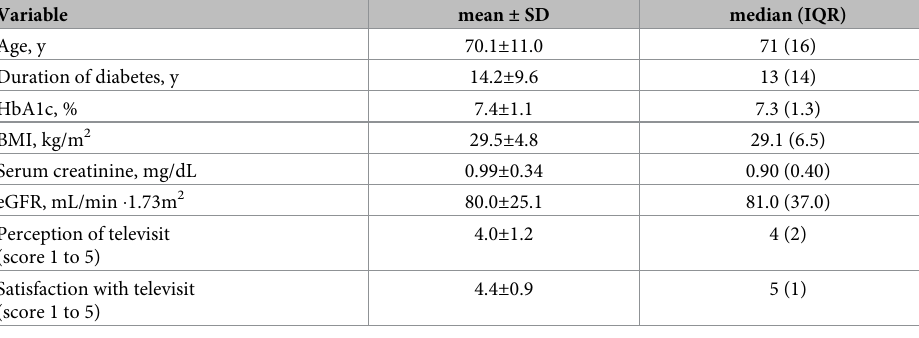
Table 1. Characteristics of T2DM patients enrolled in the study (n = 250; male/female: 60%/40%).